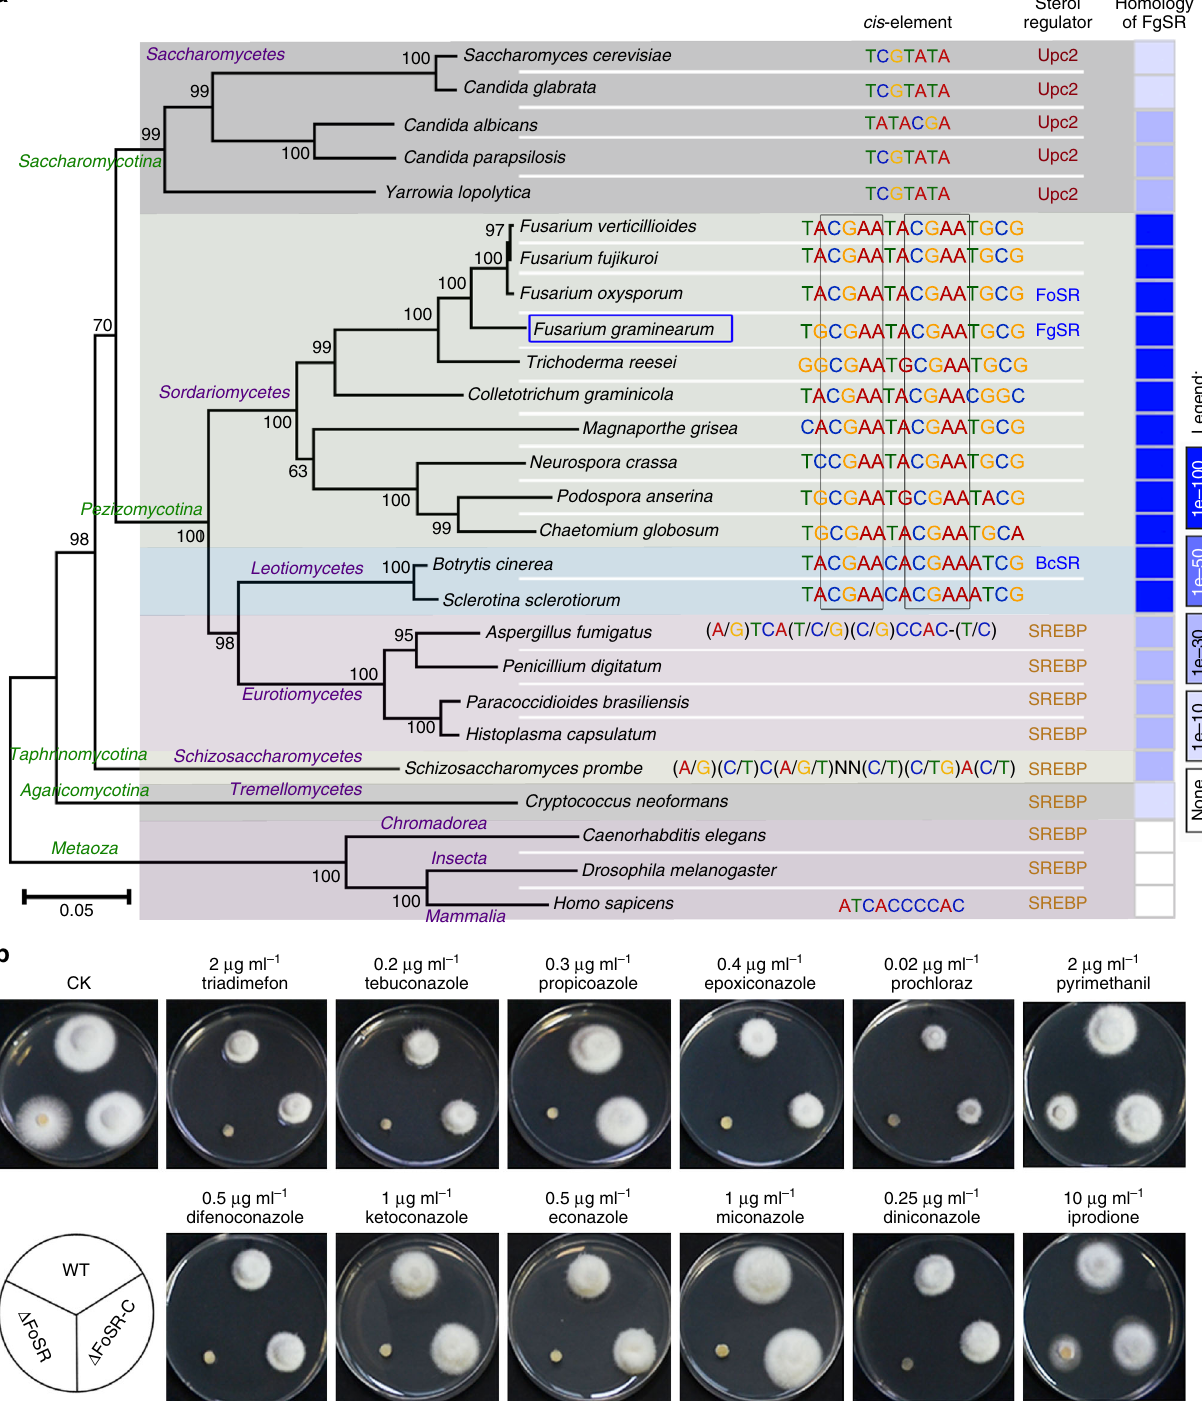
Fig. 8 FgSR homologs and their binding cis -element are highly conserved in Sordariomycetes and Leotiomycetes fungi. a FgSR orthologs share high homology in Sordariomycetes and Leotiomycetes fungi, and the FgSR-binding cis -elements within the 1.2-kb promoters of the CYP51 orthologous genes were also detected only in these fungi. The phylogenetic tree was constructed based on the amino acid sequences of RPB2 from 27 eukaryotic species with Mega 5.0 using the neighbor-joining method. The bootstrap values from 1000 replications are indicated on the branches. The homology among FgSR orthologs from 27 species were analyzed using the BLASTMatrix tool on the Comparative Fungal Genomics Platform (http://cfgp.riceblast.snu.ac.kr/). The depth of blue color on the right indicates the level of homology with FgSR. b Deletion of the FgSR ortholog in the Sordariomycetes fungus Fusarium oxysporum led to elevated sensitivity to sterol biosynthesis inhibitor (SBIs). A 5-mm mycelial plug of each strain was inoculated on PDA alone or supplemented with a SBI compound, and then incubated at 25 °C for 2 days. The non-sterol biosynthesis inhibitors, iprodione and pyrimethanil, were used as a